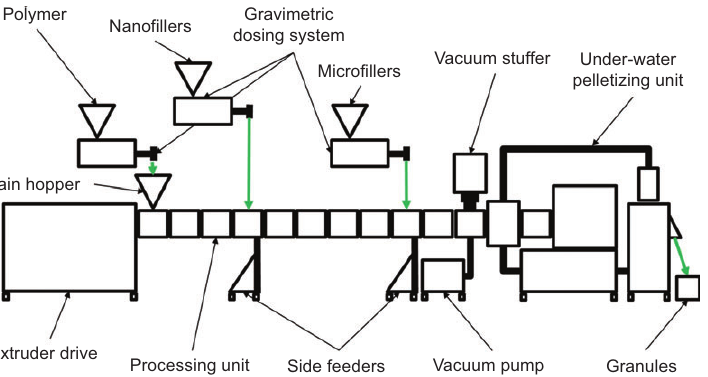
Figure 1 Setup of the compounding process for compounding short glass fiber-reinforced polypropylene-layered silicate